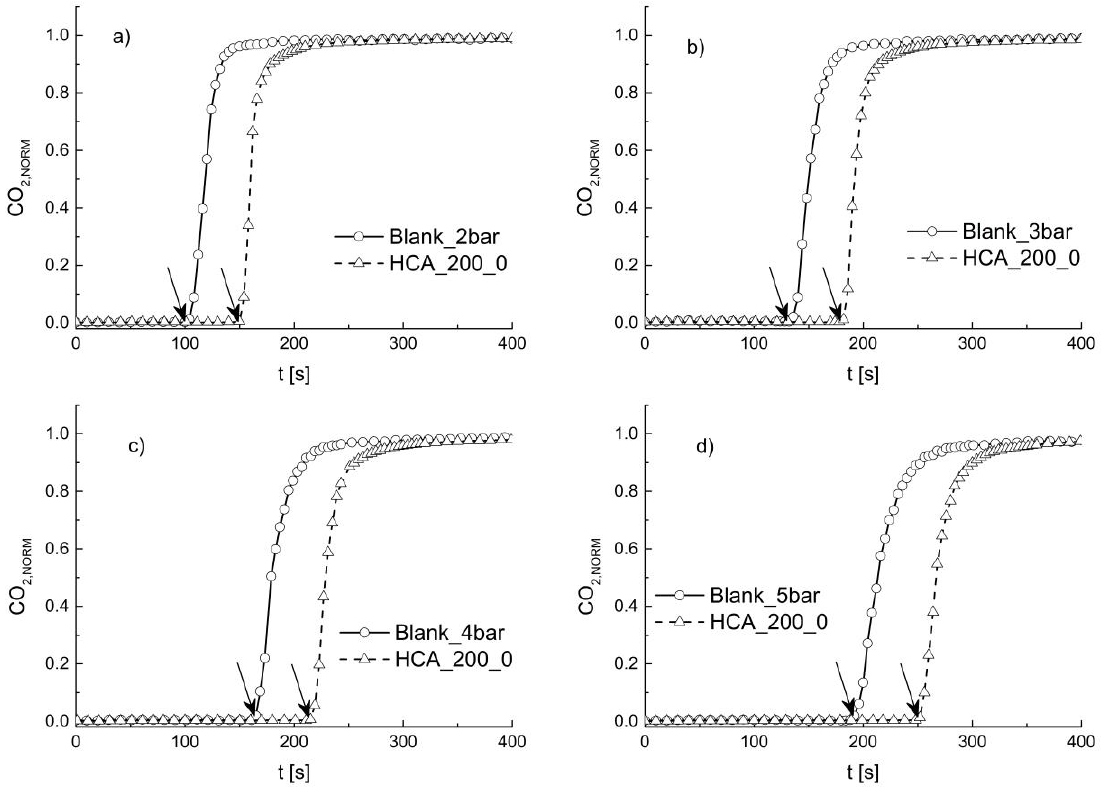
Figure 3. CO 2 / N 2 adsorption curves at ( a ) 2 bar; ( b ) 3 bar; ( c ) 4 bar; and ( d ) 5 Figure 3. CO 2 /N 2 adsorption curves at ( a ) 2 bar; ( b ) 3 bar; ( c ) 4 bar; and ( d ) 5 bar.